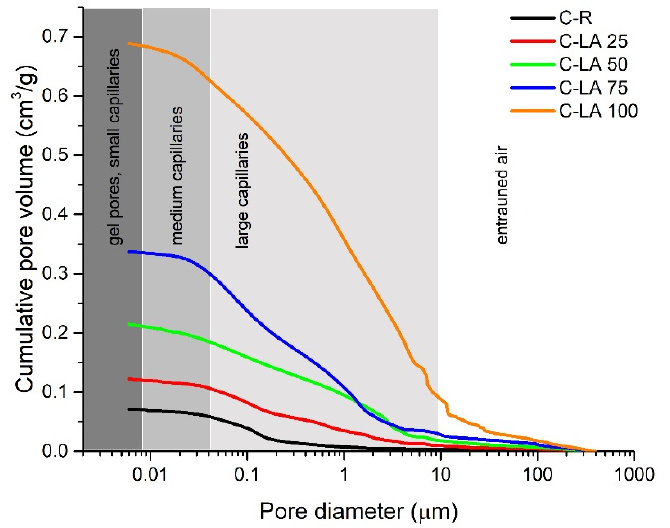
Figure 6. Pore size distribution-cumulative curves measured for control (C-R) and LA dosed samples (C-LA 25–100).